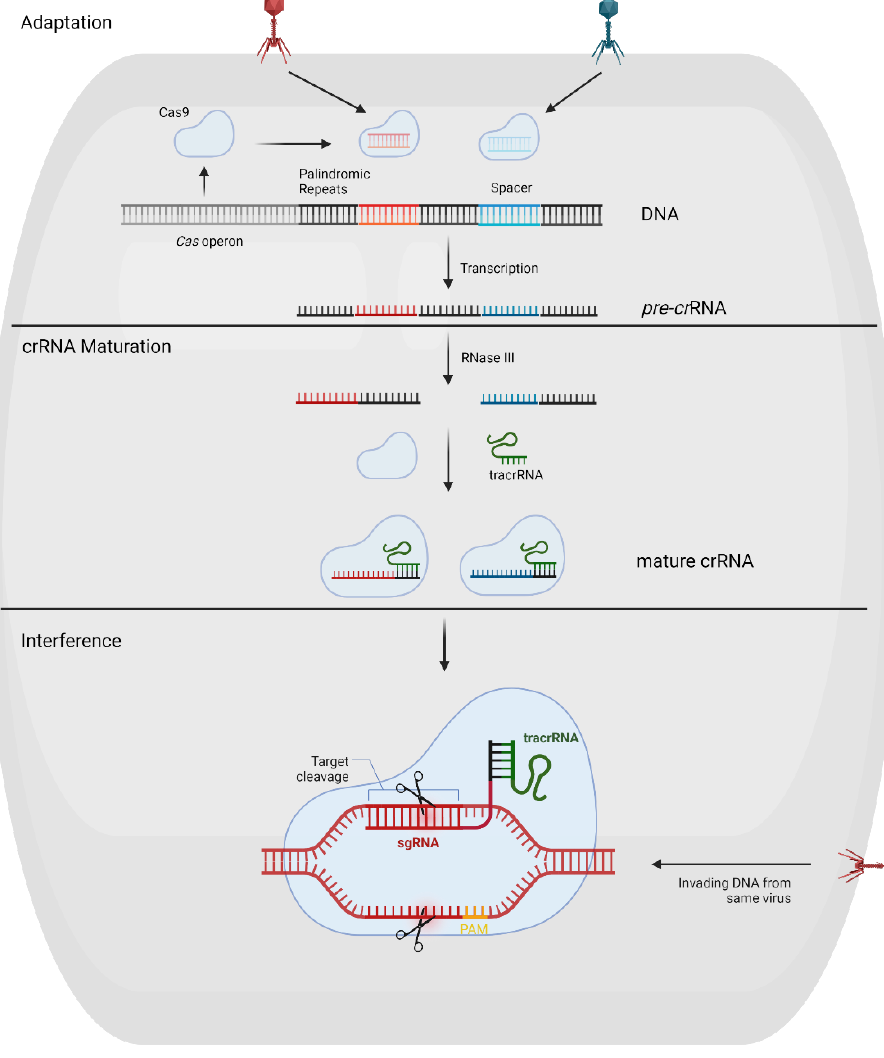
Figure 1. Schematic diagram of the CRISPR adaptive immune system against bacteriophage. (Adapted from Ref. [61] with free permission. Created with BioRender.com accessed on 20 Septem- ber 2022).